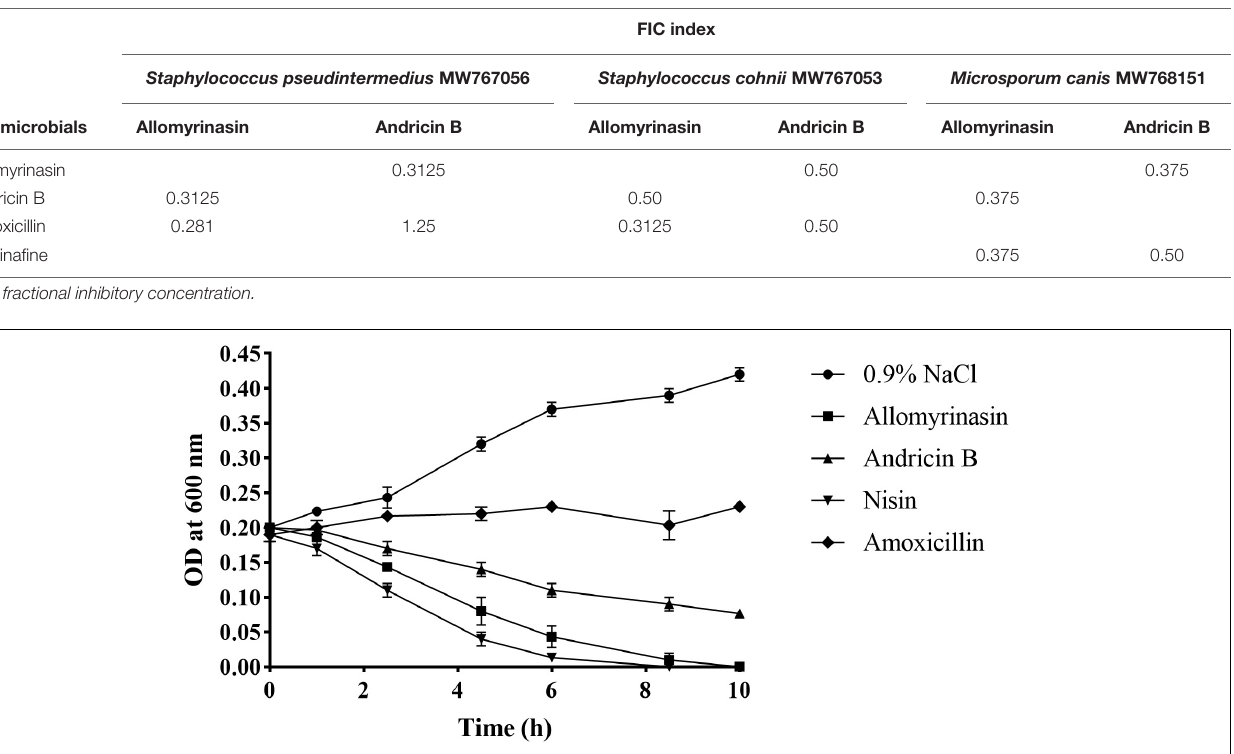
TABLE 3 | The FIC index of the tested peptides in combination with amoxicillin and terbinafine.